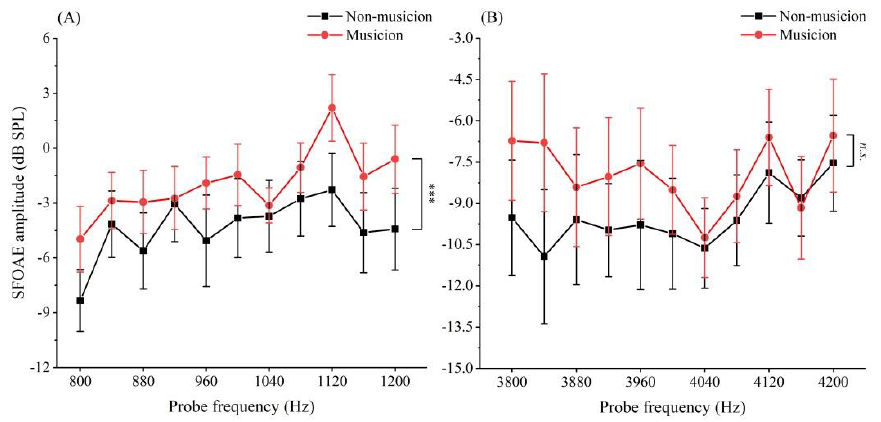
Figure 4. The mean values of SFOAE amplitudes for musicians and non-musicians as a function of fps. ( A ) Mean SFOAE fine structure at the probe frequency centered low frequency: 1 kHz; ( B ) mean SFOAE fine structure at the probe frequency centered high frequency: 4 kHz * p < 0.05, ** p < 0.01, n.s., not significant (two-factor Scheirer–Ray–Hare test). Vertical bars represent the standard errors of mean.